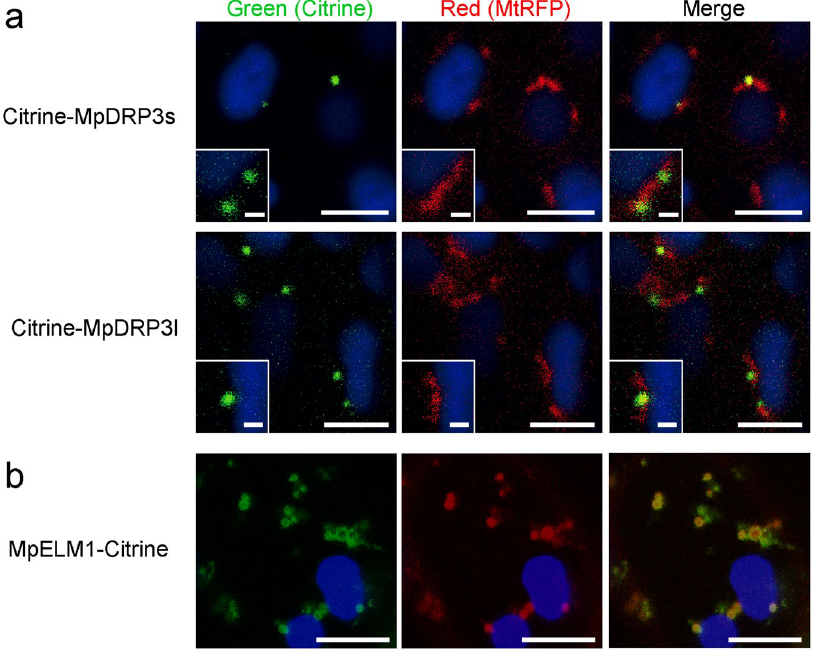
Figure 5. Complementation analysis of mutants lacking MpDRP3 or MpELM1. ( a ) CLSM observations of either Citrine-MpDRP3s or Citrine-MpDRP3l and MtRFP in Mp drp3 by using the particle bombardment (Bars = 5 µ m). Those were transiently expressed under the control of the CaMV 35 S promoter. Magnified images are shown in insets (Bars = 1 µ m). ( b ) CLSM Images of MpELM1-Citrine and MtRFP in Mp elm1 (Bars = 5 µ m). Blue signals were chlorophyll